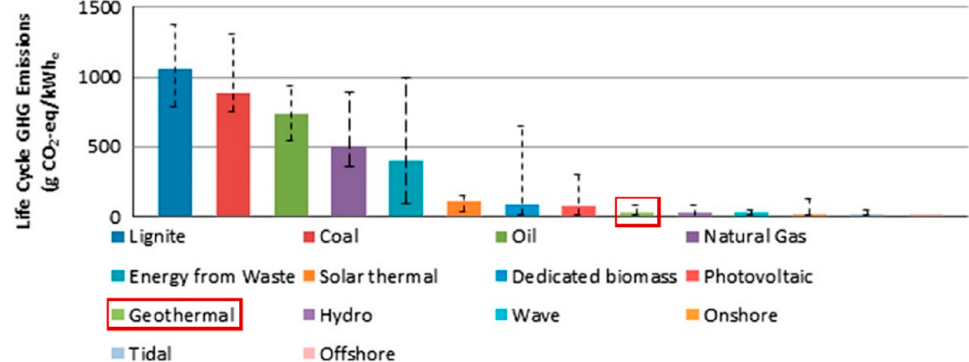
Figure 9. Life cycle GHG emission estimates from various electricity generation methods [43].